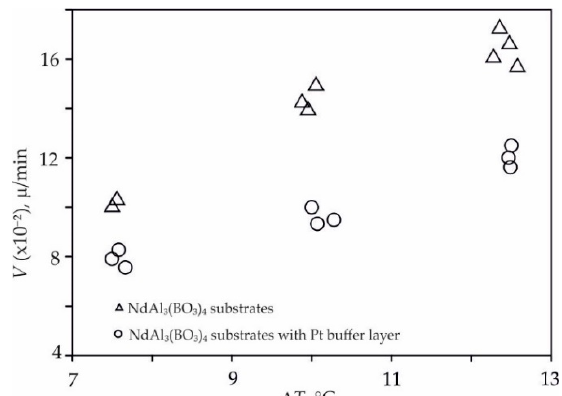
Figure 5. Normal growth rate vs. relative supercooling for NAB epitaxial layers obtained from a 28–71 wt% (69.4 wt% K 2 Mo 3 O 10 –18.1 wt% Nd 2 O 3 –12.5 wt% B 2 O 3 ) solvent [35]. Reprinted from the Journal of Crystal Growth, 401, Volkova E., Maltsev V., Kolganova O., Leonyuk N.I., High-temperature growthandcharacterizationof(Er,Yb):YAl 3 (BO 3 ) 4 andNdAl 3 (BO 3 ) 4 epitaxiallayers, 547–549, Copyright